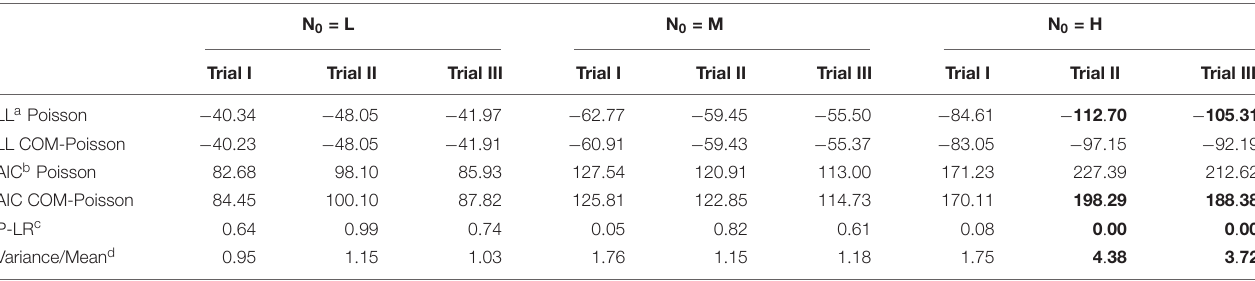
TABLE 2 | Log-likelihood (LL) value, P of likelihood ratio test (P-LR), Akaike information criterion (AIC) and variance-to-mean ratio to determine the better-fitted distribution for the initial observed L. monocytogenes counts (LnN 0 : Ln CFU/0.2 mL) in each of the three trials, starting with different initial cells (L, low inoculum; M, medium inoculum; H, high